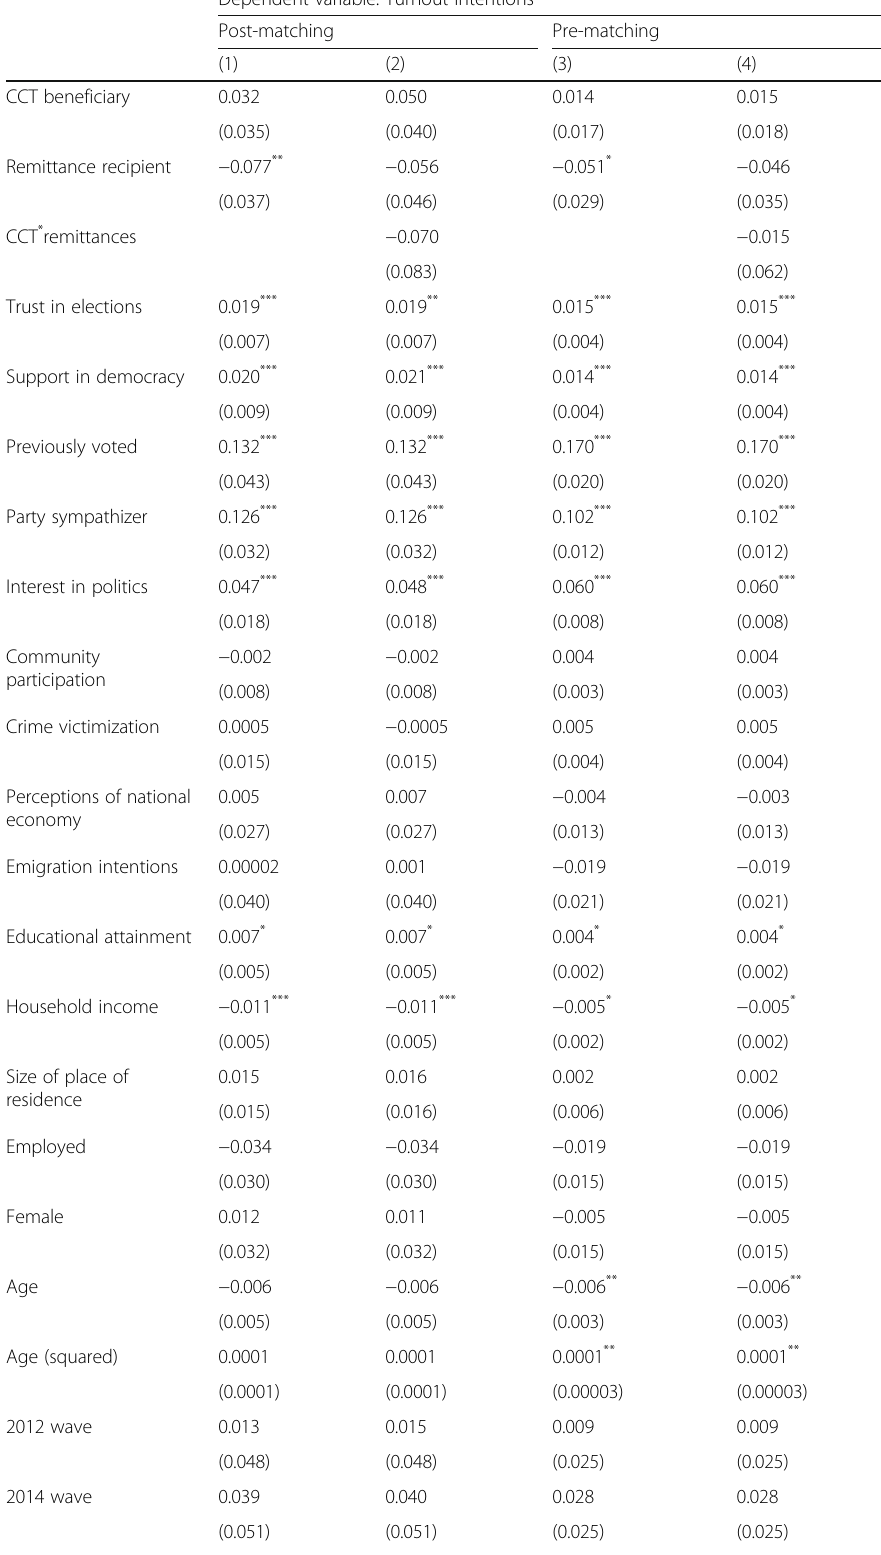
Table 3 Linear probability